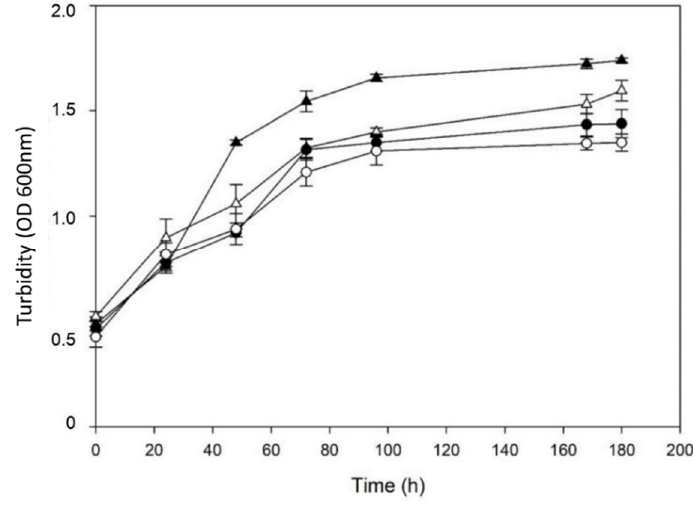
Figure 5. Growth curves were obtained from cultures of the bacterial consortium growing in media composed of TW and different concentrations of PS. The bacterial consortium was grown in TW added with the following PS concentrations: (solid triangles) 700 ppm, (open triangles) 1048 ppm, (solid circles) 1398 ppm, and (open circles) 1748 ppm. The curve for each condition is obtained by calculating the average of three replicates. The details of the cultivation procedure are given in the Materials and Methods section.